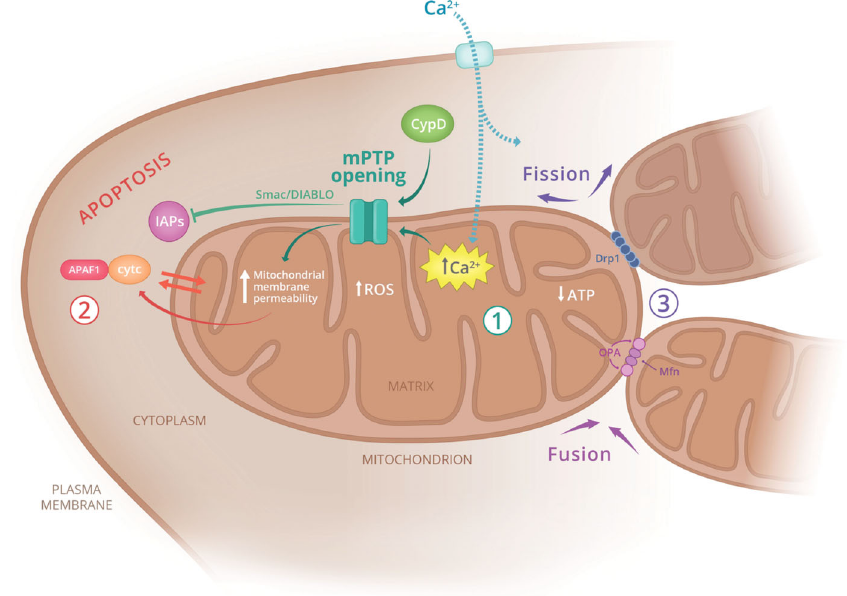
Fig. 1 Mitochondrial damage contributes to a wide range of pathologies. The main pathways leading to mitochondria-associated cellular dysfunction include (1) calcium overload in the matrix and mPTP pore opening, (2) cytochrome c release and activation of apoptosis, and (3) defects in mitochondrial fi ssion and fusion affecting mitochondrial longevity. APAF1 apoptotic protease activating factor 1, ATP adenosine triphosphate, CypD cyclophilin D, cytc cytochrome c, Drp1 dynamin-related protein 1, IAPs inhibitor of apoptosis proteins, Mfn mitofusin, mPTP mitochondrial permeability transition pore, OPA optic atrophy mitochondrial fusion protein, ROS reactive oxygen species, Smac/DIABLO pro-apoptotic mitochondrial compensate with cellular redox homeostasis. To repair the membrane damage caused by lipid ROS, the lipid hydroperox- idase glutathione peroxidase 4 (GPX4) converts lipid ROS to non- toxic lipid alcohols 20 . However, with increased iron accumulation and ROS production, or depletion of glutathione and decreased activity of GPX4, lipid ROS accumulate; this leads to ferroptosis